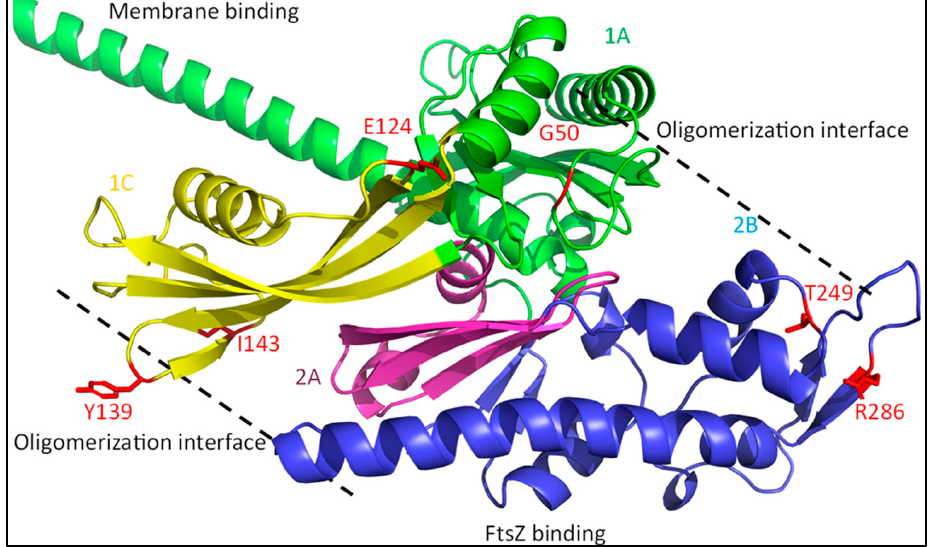
Figure 7. FtsA structure. FtsA in a cytoplasmic protein that binds to the inner membrane and acts as a membrane anchor for FtsZ. FtsA is divided into four domains which interact with different divisome components [81]. The 1A domain (green) is involved in membrane binding and has also been linked to FtsK binding (see text). The 2B domain (blue) contains a region that binds FtsZ and, together with the 1A and 2A domains, forms a nucleotide (ATP)-binding pocket at the FtsA core. The 1C domain (yellow) is involved in the recruitment of FtsN. FtsA oligomerizes through 1A–1C and 2A–2B interactions. Multiple SF mutants are shown in red, which are mostly located at the oligomerization interfaces.